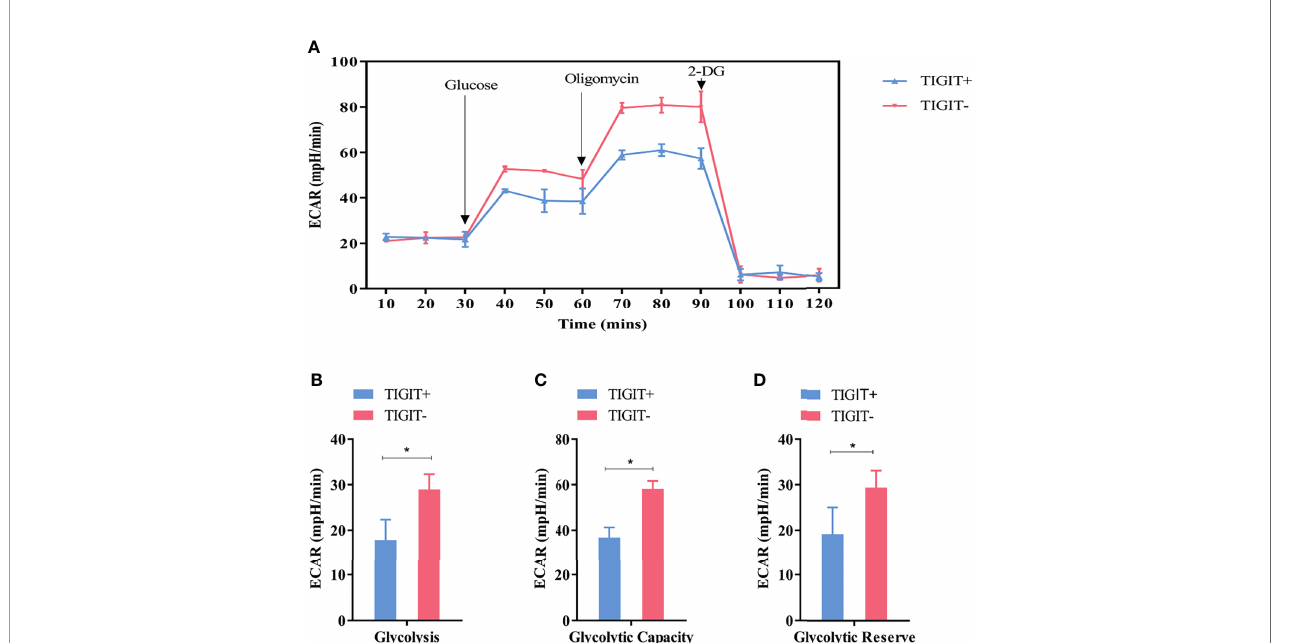
FIGURE 4 | Measurement of ECAR in TIGIT + T and TIGIT - T cells. (A) Kinetic ECAR response of TIGIT + T and TIGIT - T cells. (B – D) Measurement of Glycolysis, Glycolytic Capacity and Glycolytic Reserve. * P < 0.05.